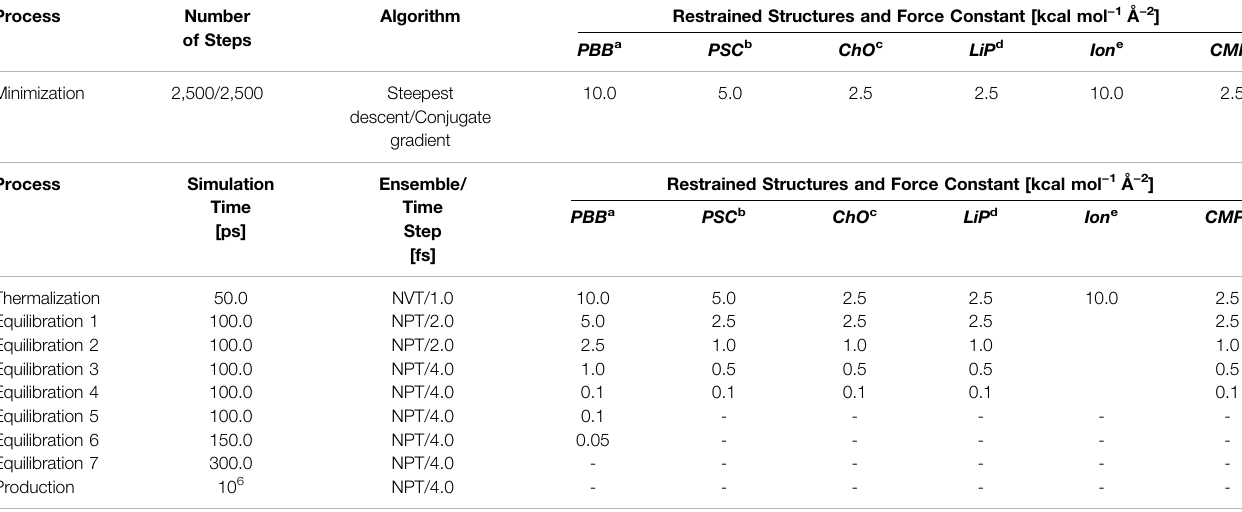
a protein backbone. b protein side-chain heavy atoms. c cholesterol oxygen atoms. d lipid phosphorus